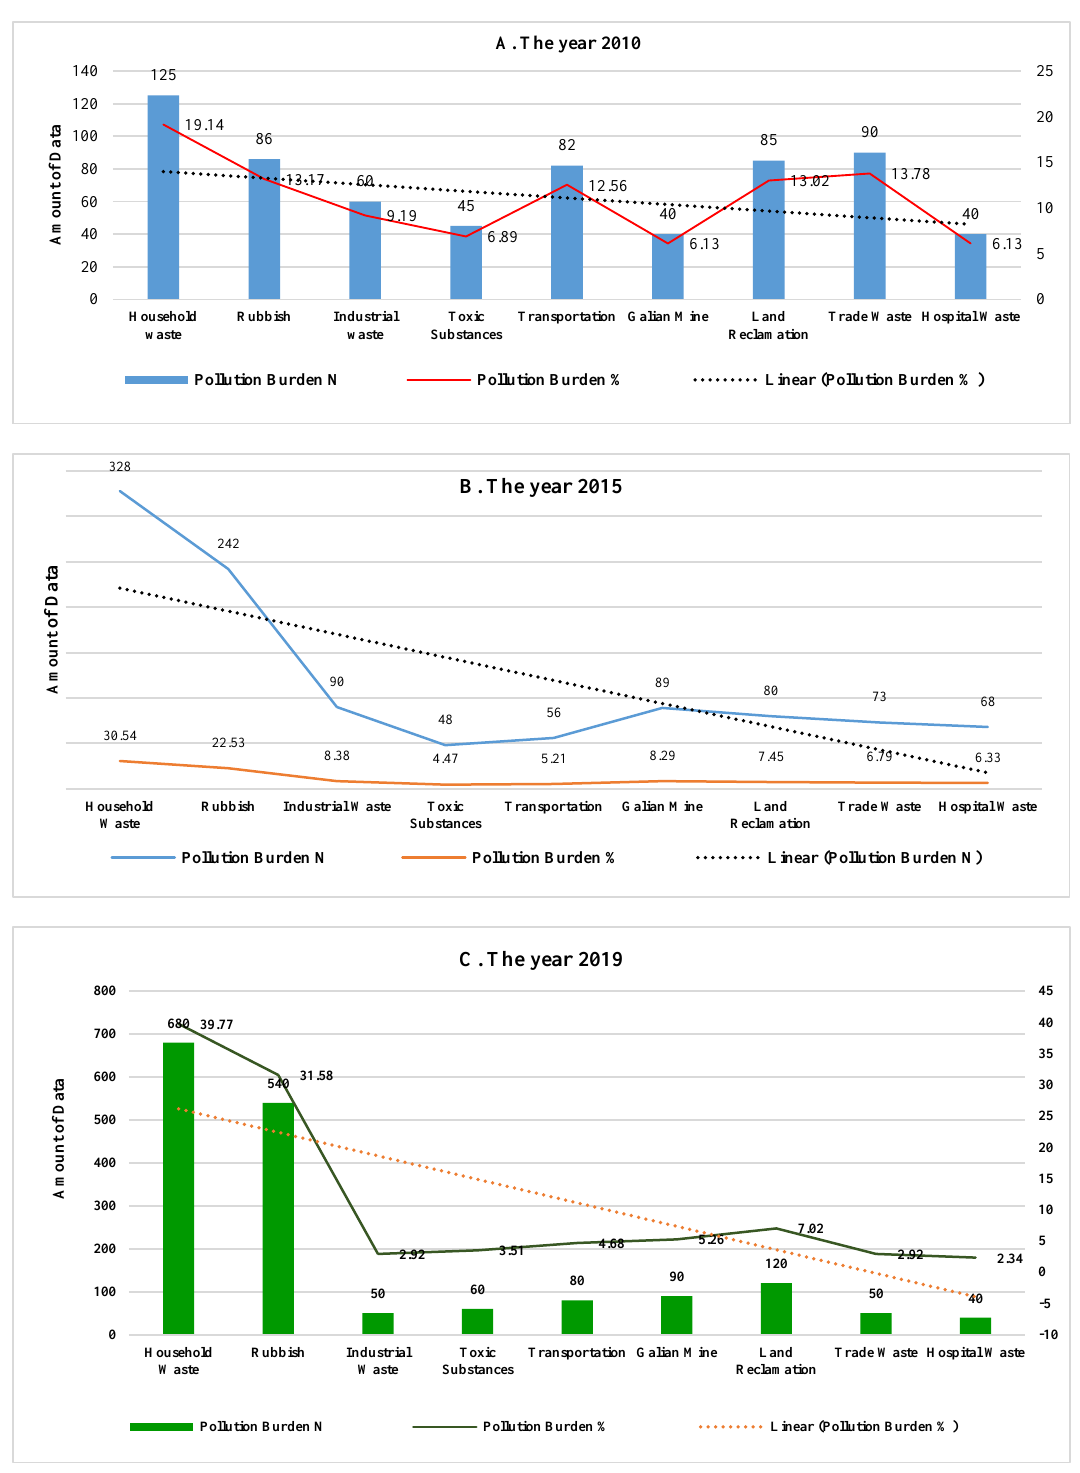
Figure 9. Load and Sources of Environmental Pollution in the Tallo River Basin in Makassar City (2010–2019). Source: author elaboration and Data Primer.